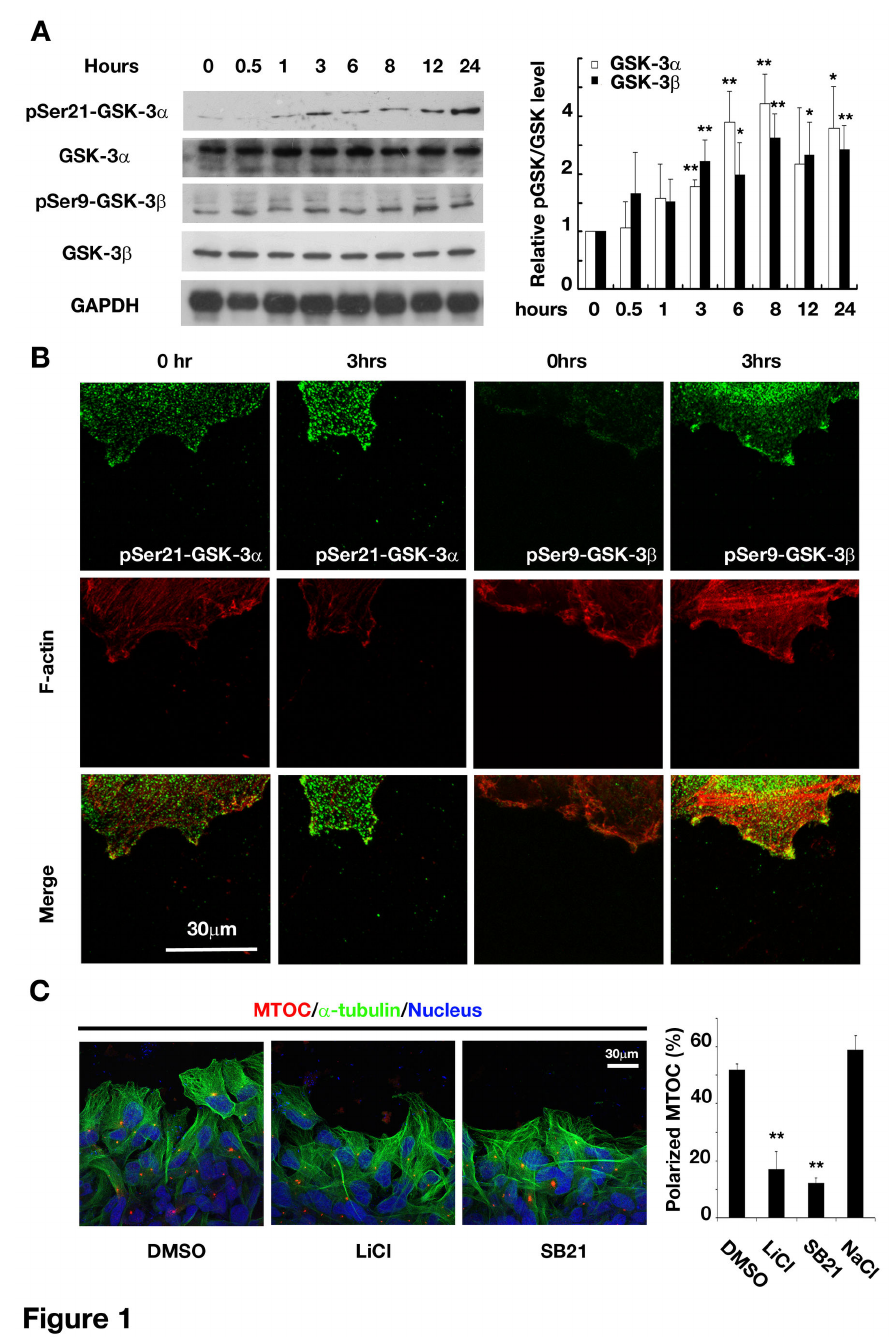
Figure 1. Localized inactivation of GSK-3β was associated with the formation of cell polarity. (A) Up-regulation of pSer- GSK-3 during the wound recovery of U251 cells. Left : representative western blot results of U251 cell lysates collected at indicated time points after scratching. Right : statistics of p-Ser-GSK-3 levels normalized to GSK-3 levels and compared with the value at 0hr. * P <0.05, ** P <0.01 versus the value of pGSK-3/GSK-3 at 0hr. (B) Location of increased pGSK-3 staining in the wound recovery of U251 cells at 0 hr or 3 hrs after scratching. Green: anti-pSer21-GSK-3α or anti-pSer9-GSK-3β; Red: rhodamine phalloidin. Original magnification, 400× .(C) MTOC mis-orientation in U251 caused by GSK-3 inhibitors. Left : representative images of MTOC in different treatments. Green: anti-α-tubulin; Red: anti-pericentrin; Blue: Hoechst 33258. Original magnification, 400× . Right : quantification of centrosome polarization as described in Materials and Methods in U251 with or without GSK-3β inhibitors. ** P <0.01 versus DMSO. LiCl 20mM, SB216763, 20μM, NaCl, 20 mM. Data were mean ± SD of three independent experiments. doi: 10.1371/journal.pone.0081814.g001 PLOS ONE |